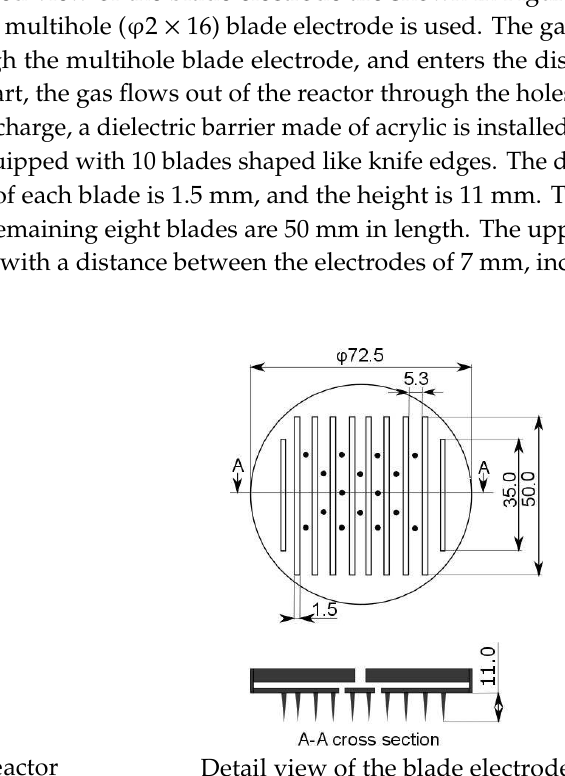
Figure 1. Schematic diagram of the plasma reactor and detail view of the blade electrode.